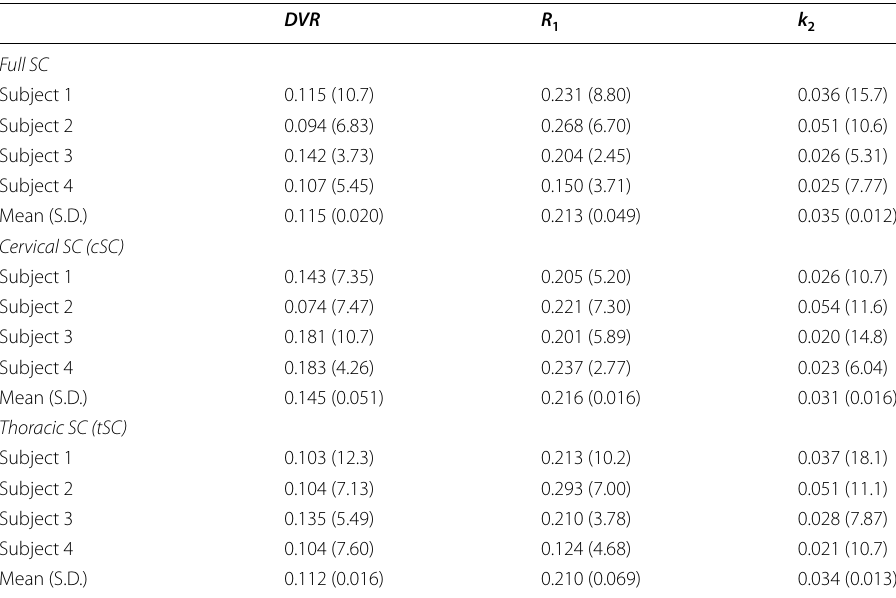
Table 3 Parameter estimates (%standard error) from SRTM2 fits of automated SC, cSC, and tSC ROI TACs for individual subjects along with mean and SD for 4 subjects DVR R 1 k 2 Full